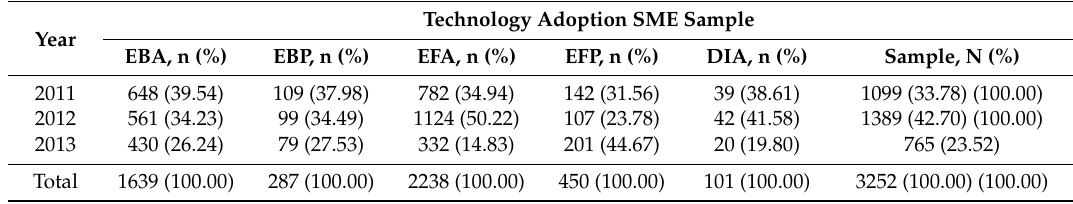
Table 3. Distribution of technology adoption SMEs,